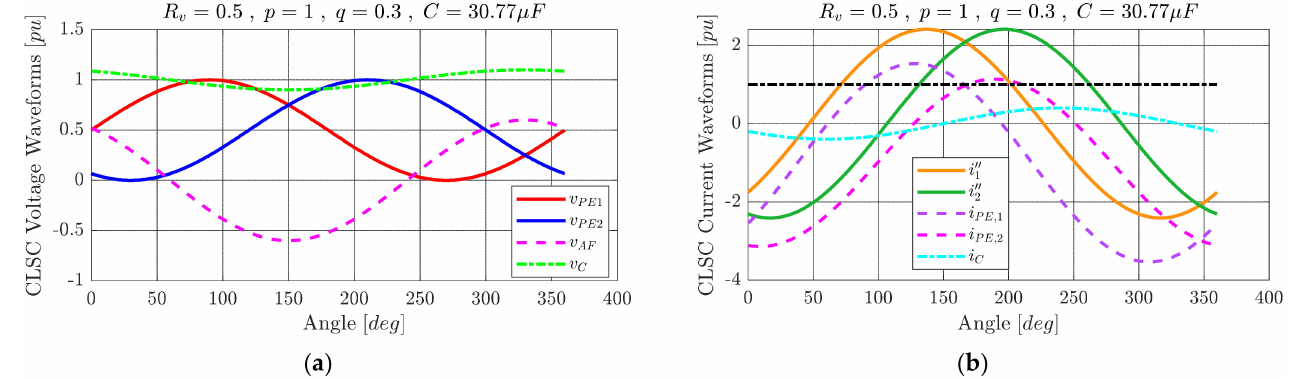
Figure 14. Open-delta CLSC voltages ( a ); and currents ( b ) for p = 1, q = 0.3, and R v = 0.5. The maximum and minimum currents flowing through the converter stacks are shown in Figure 15. Again, it can be noticed that the max and min voltages increased linearly with R v while the maximum and minimum currents were proportional to 1/ R v . Additionally, a DC component was noticeable in the PE voltages, PE currents, and AF current.